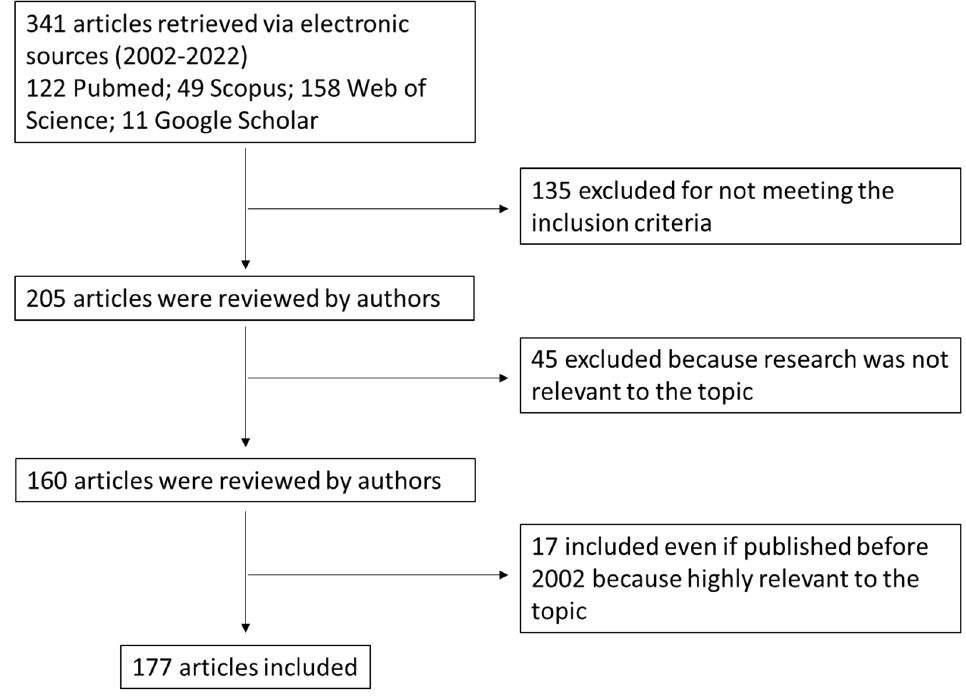
Figure 1. Graphical scheme of bibliographic search.